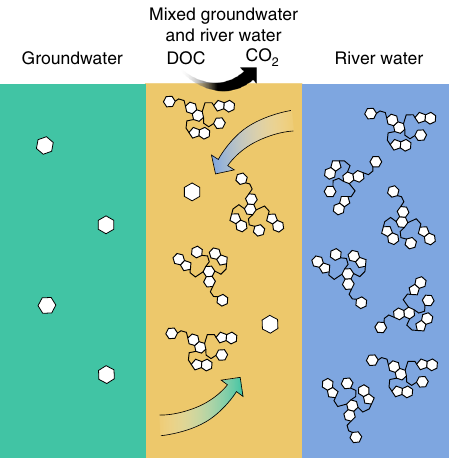
Fig. 1 Hypothesized mechanism underlying the stimulation of respiration by mixing of groundwater with river water: low concentration of DOC protects thermodynamically favorable C (represented as monomeric C) by imposing an energetic limitation in terms of low total energy across the DOC pool, allowing favorable DOC to accumulate in GW. The thermodynamically unfavorable state of DOC (represented as polymeric C) in RW protects it from microbial oxidation, allowing it to accumulate in RW despite the DOC of RW being at a higher concentration. GW – RW mixing increases DOC concentration, relative to GW (removing the energetic protection), and improves DOC thermodynamic favorability (removing thermodynamic protection). Simultaneously removing these protection